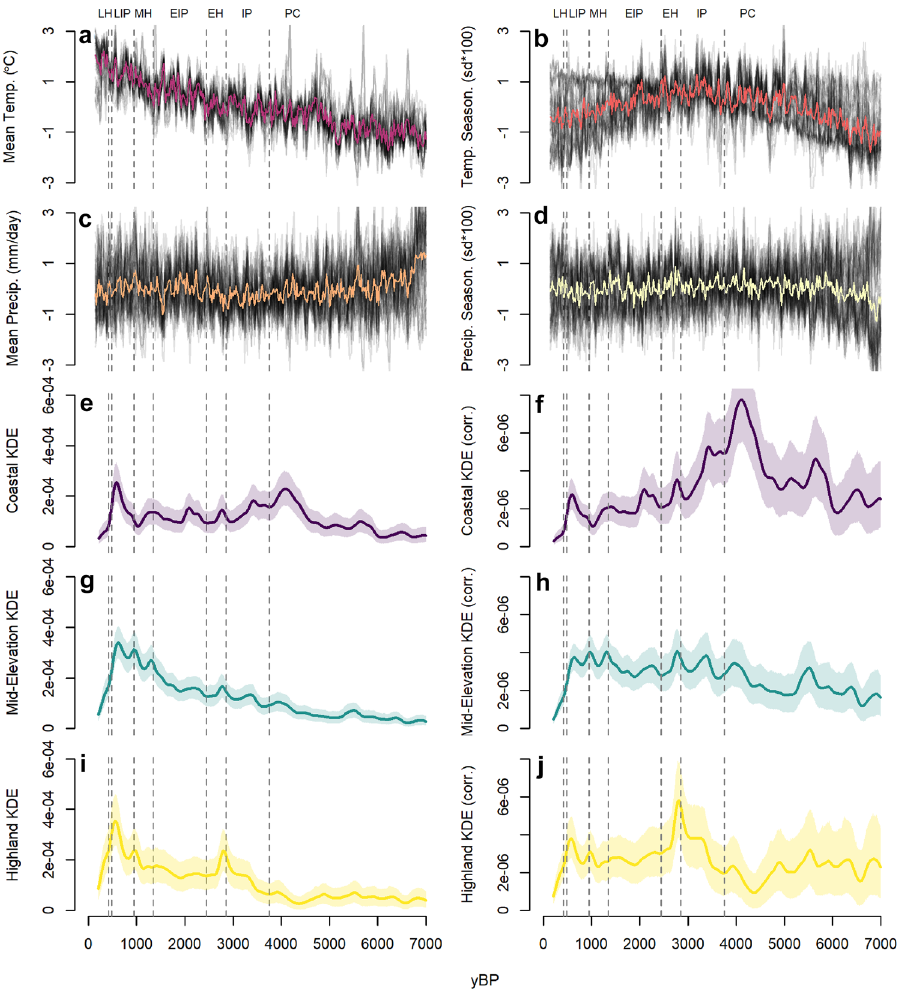
Figure 2. Time series of climate and demographic variables. ( a–d ) z-scores of temporal climate deviation from the mean for the past 7000 years. Each grey line represents the z-score variation of an individual grid cell (see Fig. 1). Colored lines represent the moving average z-score for all raster grid cells combined. In order, the variables are ( a ) mean temperature (°C), ( b) temperature seasonality (sd °C * 100), ( c ) mean precipitation (mm/ day), and ( d ) precipitation seasonality (sd mm/day * 100). ( e–j ) Coastal, mid-elevation, and highland KDE estimates documenting relative variation in population size over time for each elevation category employing uncorrected (left) and taphonomically corrected (right) KDEs. For analytical purposes, individuals receive climate value estimates from the time series of the grid cell at their spatial coordinates, not the moving average central tendency